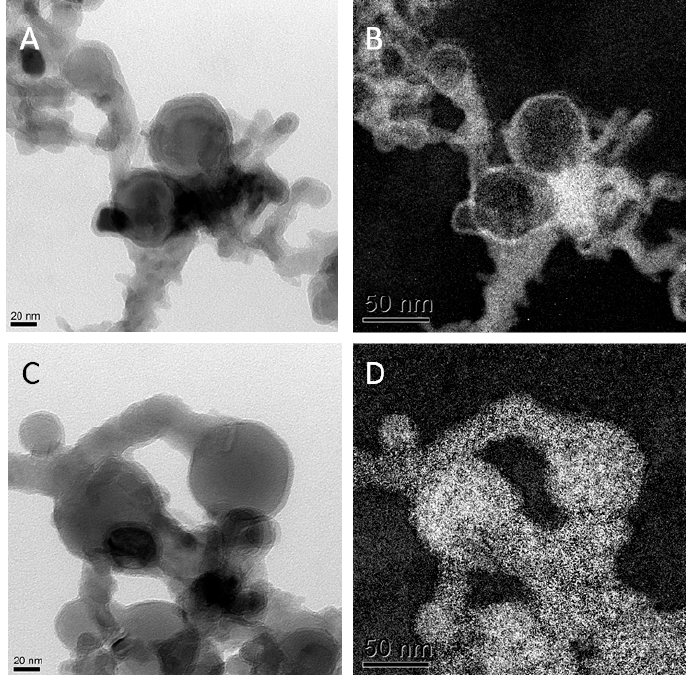
Figure 1. Transmission electron microscopy (TEM) results: ( A ) TEM pictures of Al 0 NMs; ( B ) oxygen mapping of left TEM picture; ( C ) TEM picture of Al 0 NMs; ( D ) aluminum mapping of image in C.